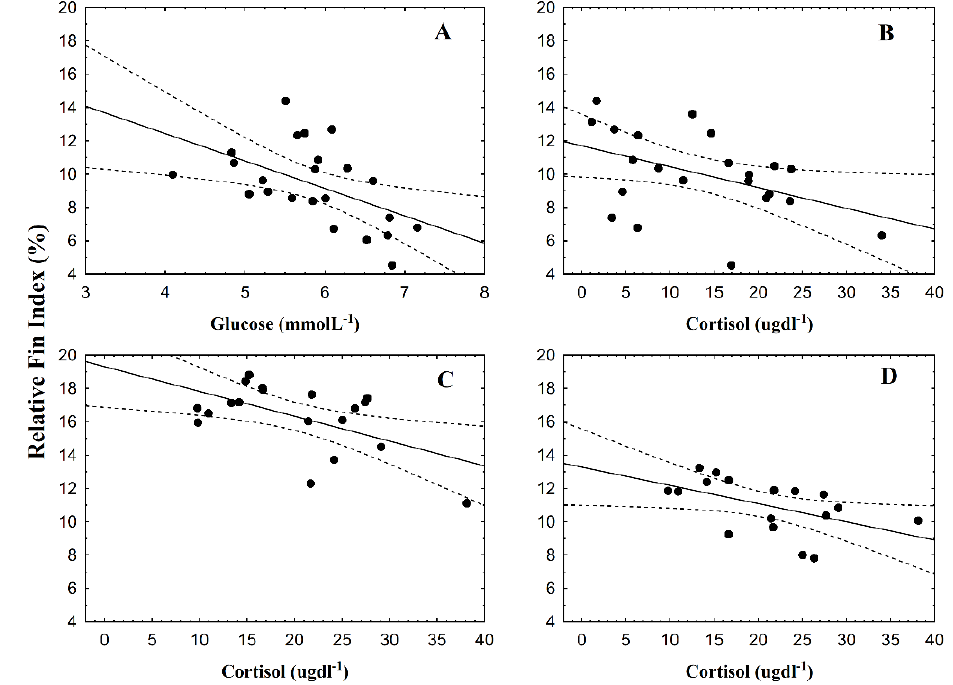
Figure 4. Linear relationships between the mean relative fin index (%) and Caligus rogercresseyi plasma glucose and cortisol levels of Atlantic salmon ( Salmo salar ) for ( A , B ) dorsal fin at 16 dpi, ( C ) for pectoral at 22 dpi, and ( D ) pelvic fin at 22 dpi.